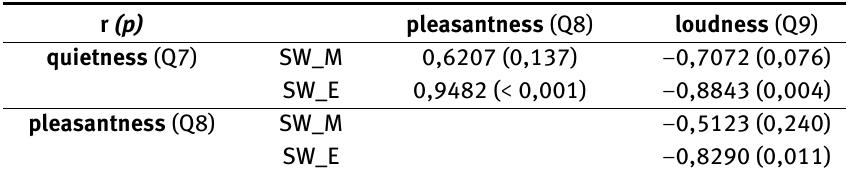
Table 7: Pearson’s correlation coeflcient and corresponding p-values (r,p) analysis for Q7 (quietness) vs Q8 (pleasantness) and Q9 (loud- ness) and Q8 vs Q9 during morning and evening